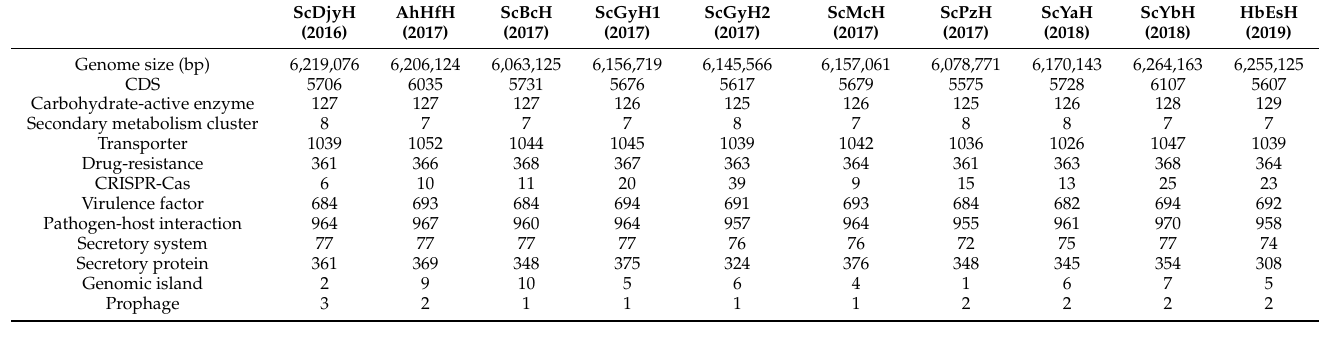
Table 1. Genomic analysis of the Psa strains.